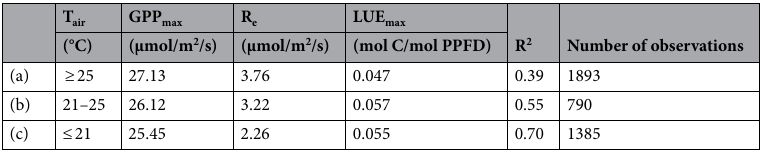
Table 1. Parameters of three nonlinear hyperbolic